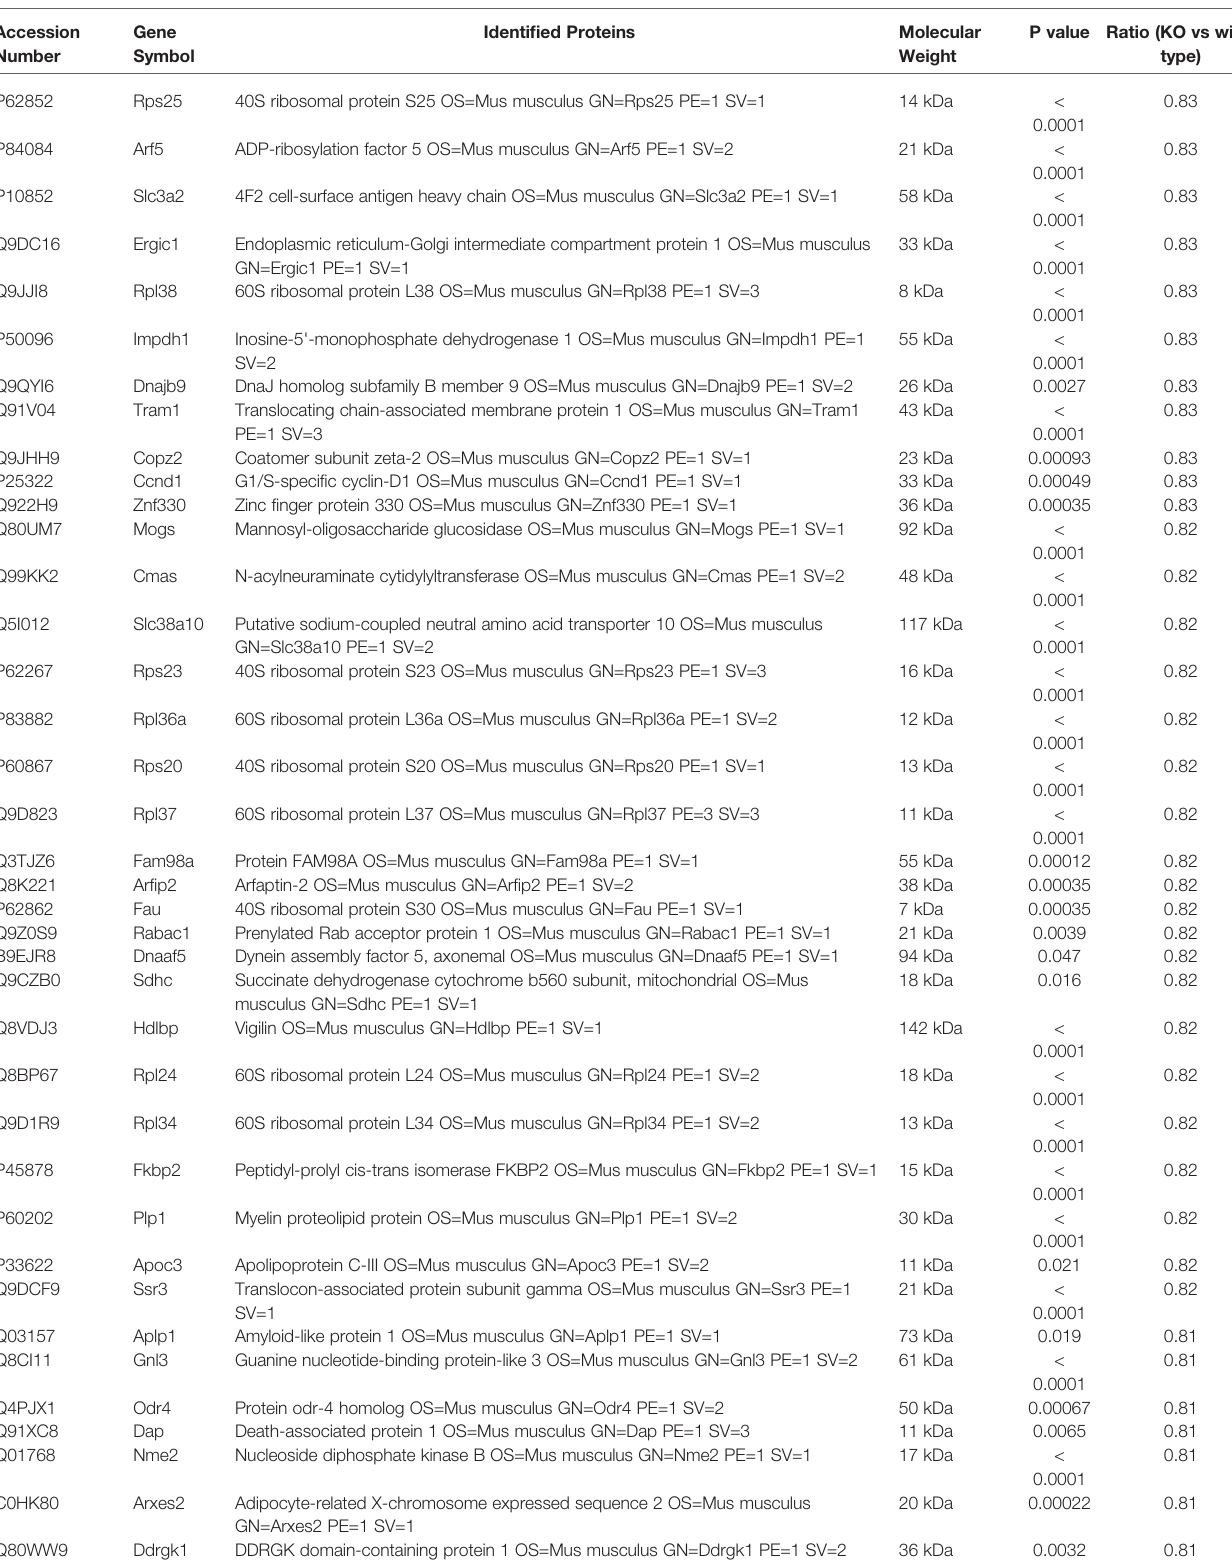
Nucleoside diphosphate kinase B OS=Mus musculus GN=Nme2 PE=1 SV=1 Adipocyte-related X-chromosome expressed sequence 2 OS=Mus musculus GN=Arxes2 PE=1